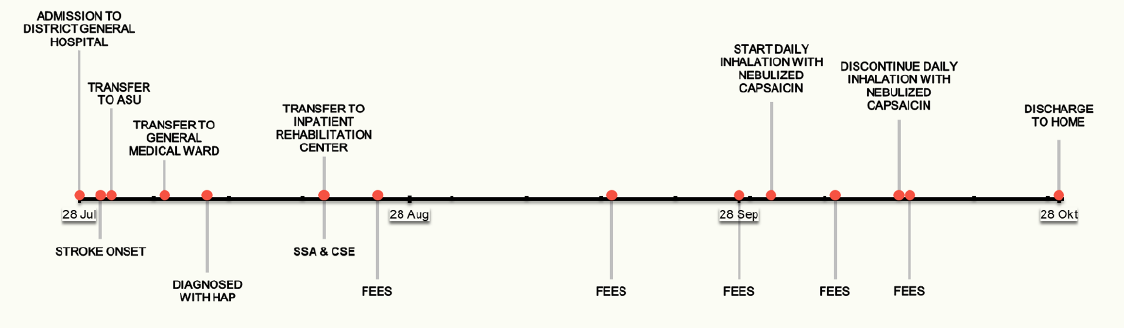
Figure 1. Timeline of the patient’s episode of care. ASU, Acute Stroke Unit; CSE, Clinical Swallowing Evaluation; FEES, Fiberoptic Endoscopic Evaluation of Swallowing; HAP, Hospital Acquired Pneumonia; SSA, Standardized Swallowing Assessment.